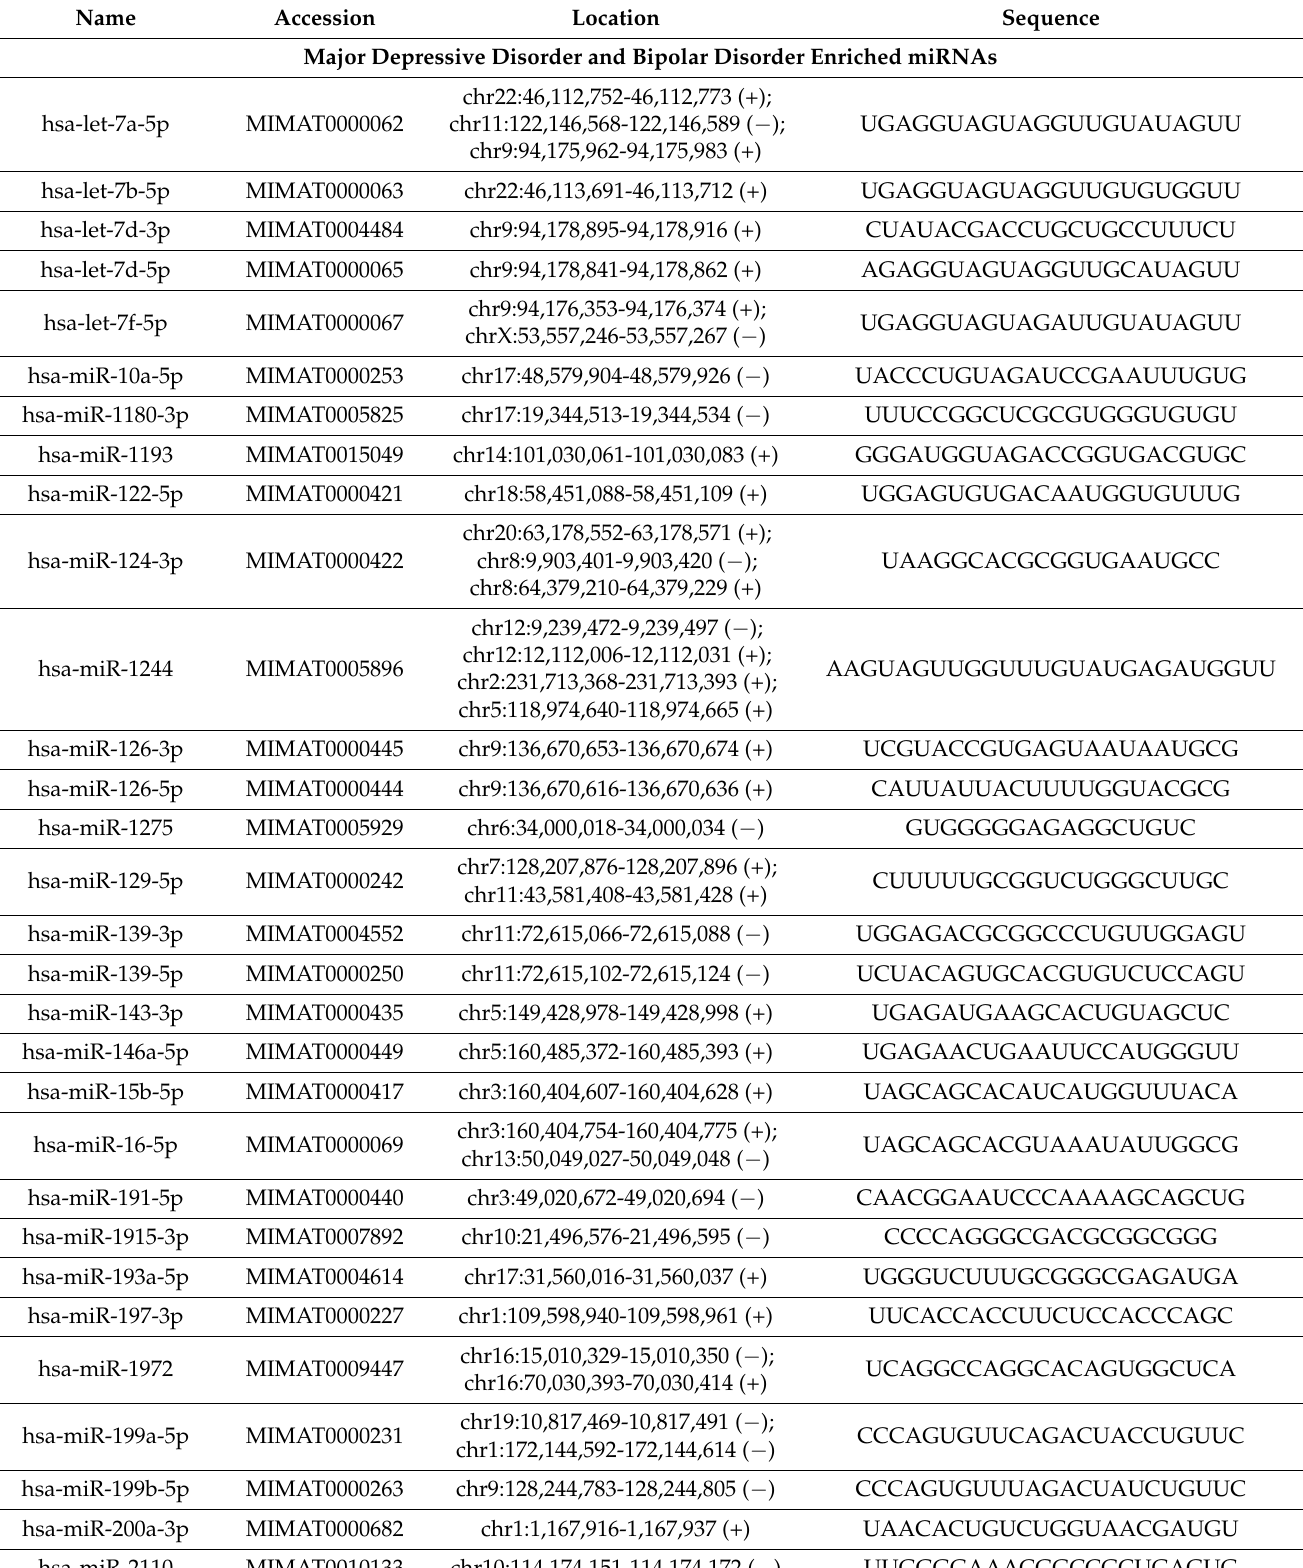
Table 2. Chromosomal Coordinates and Complete Sequence of Major Depressive Disorder and Bipolar Disorder Enriched